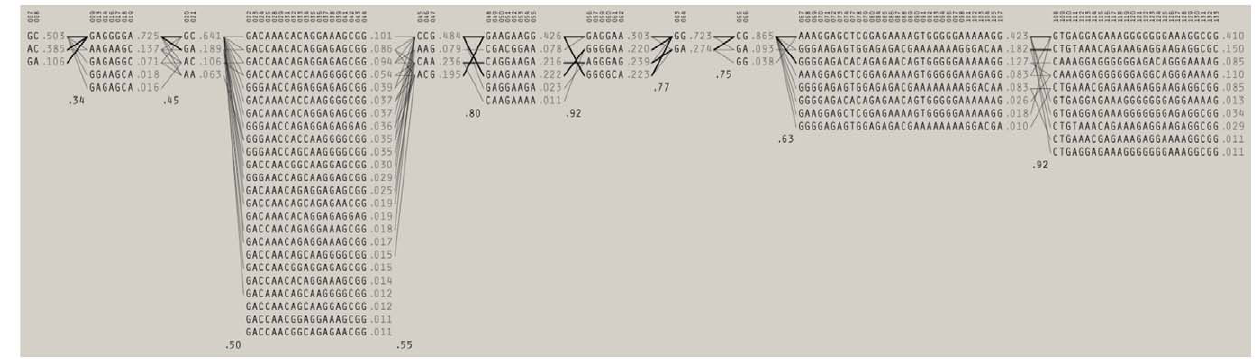
Figure 2. The nine most common SNP haplotypes. Common haplotypes and estimated haplotype frequencies as determined using Haploview across the region under survey. Numbers on top of the figure indicate the ‘SNP number’ from the 80 kb analyzed region (refer Figure 1A) as listed in Table S2. Numbers in the middle reflect frequencies of the individual haplotype. These frequencies sum up to the numbers at the bottom because they reflect only fairly common haplotypes (i.e., the number at the end ‘0.94’, explains frequencies of 94% of individuals, the rest of the individuals have rare haplotypes).